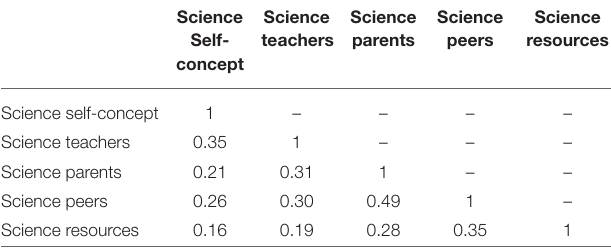
TABLE 3 | Correlations between constructs for CFA. TABLE 4 | Measurement